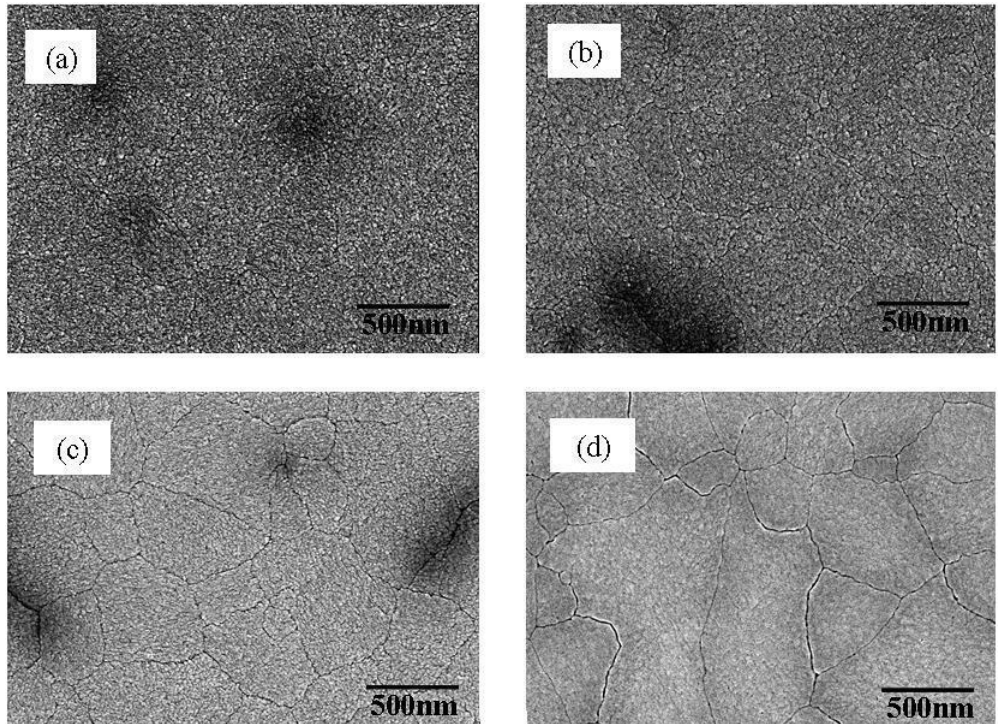
surfaces of (a) 100nmWO 3 :0.5mol%NiO (d) 200nmWO 3